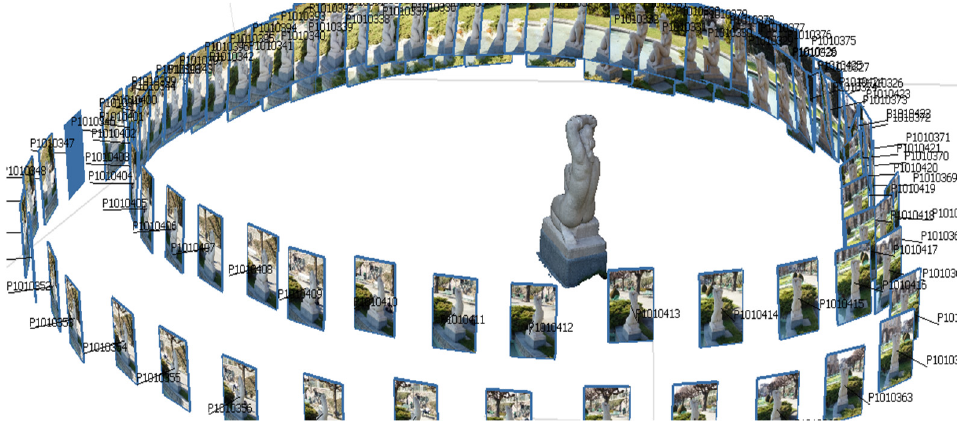
Figure 8. From a collection of stereoscopic images to a 3D model.